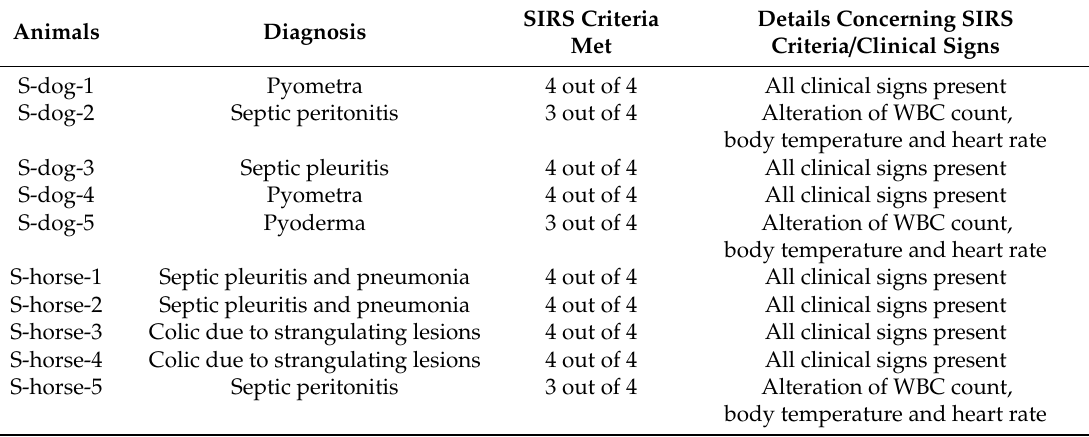
Table 2. Clinical diagnoses and SIRS criteria which lead to a diagnosis of inflammation due to bacterial infection for the 10 sick animals included (5 dogs; 5 horses). Legend: S—sick; SIRS—systemic inflammatory response